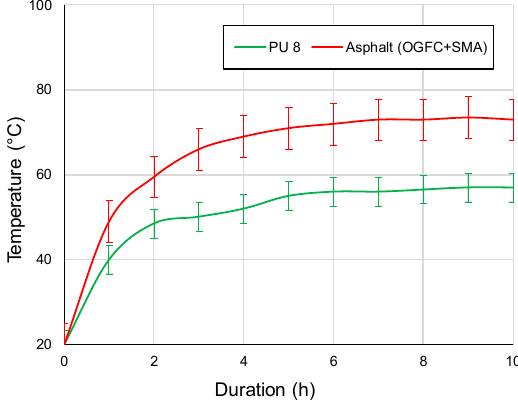
Figure 9. The different reflection results of a heat reflection surface.